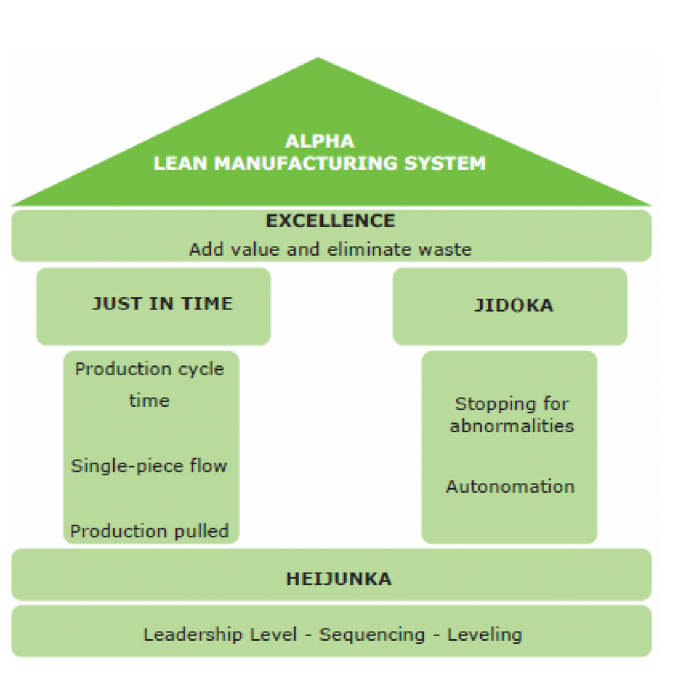
Figure 4. Alpha Lean Manufacturing